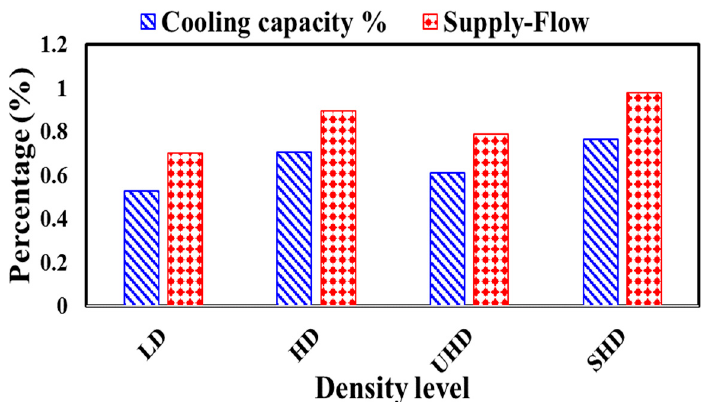
Figure 6. Yearly additional cooling capacity and supplied air flow (in percentages) by employing dry variable thermal conductivity as compared with constant values at different density levels in the hot climate of UAE.